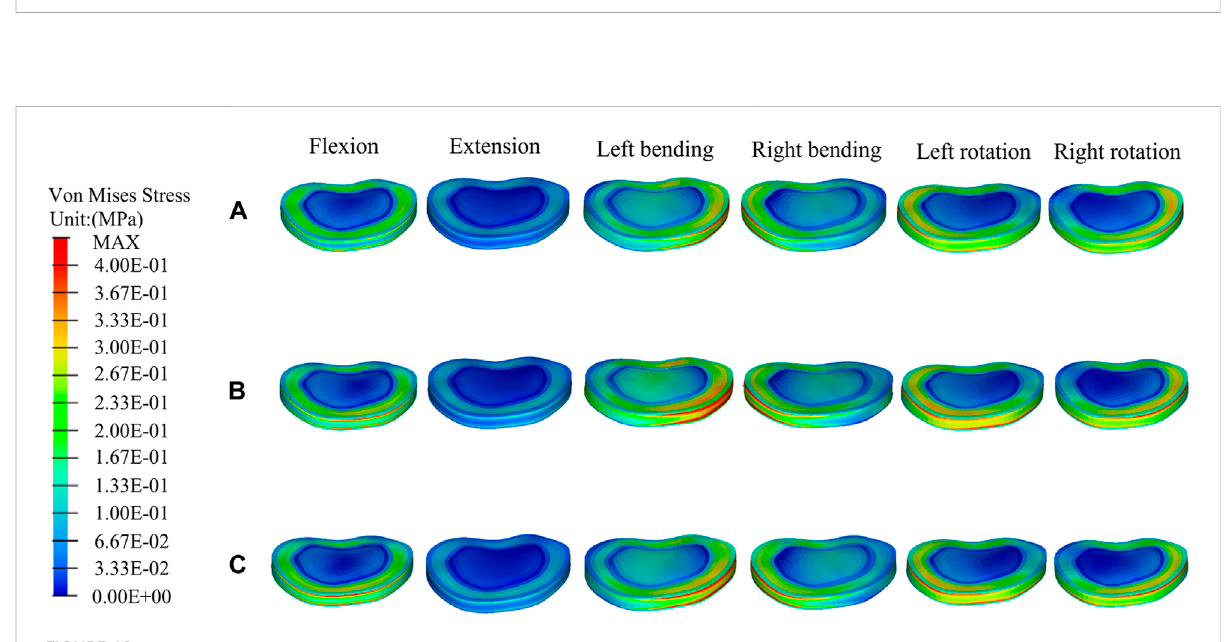
FIGURE 10 The distributions of the von Mises stress on the T12-L1disc. The distributions of the von Mises stress on the T12-L1disc in a fractured model (A) , UPVP (B) , and BPVP (C) under fl exion, extension, left/right bending, and left/right